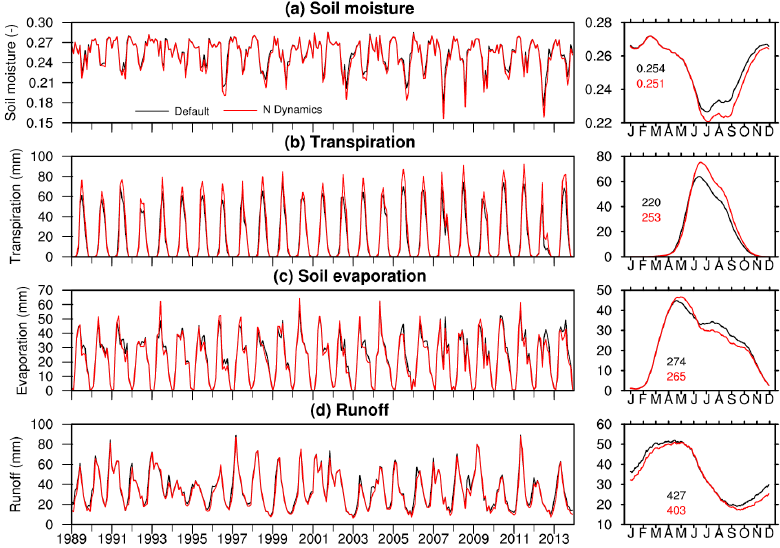
Figure 7. Same as Fig. 6 except for (a) soil moisture, (b) transpiration, (c) soil evaporation, and (d)